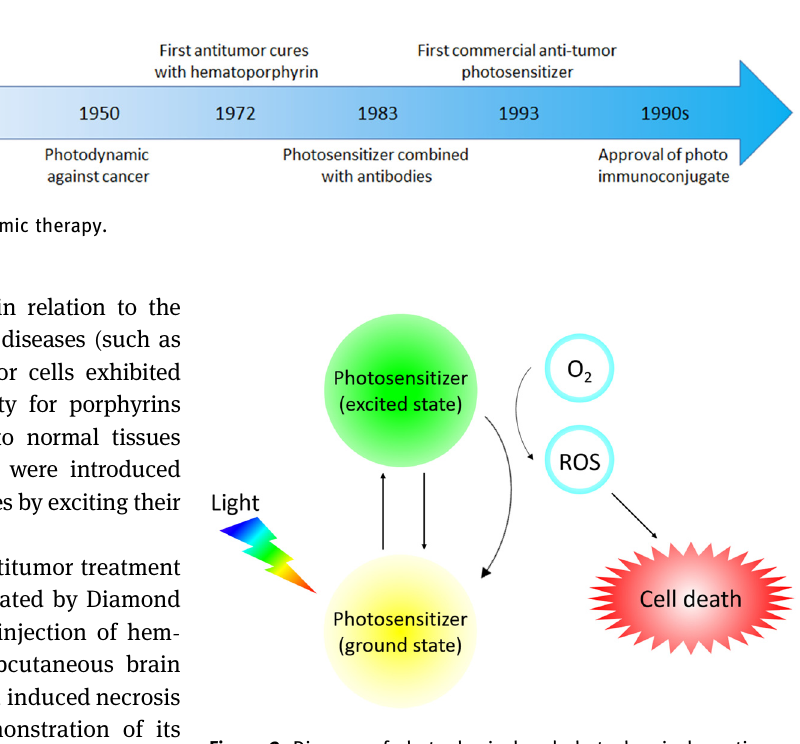
Figure 2: Diagram of photophysical and photochemical reactions during PDT. PS absorbs photons from a light source, and in its triplet excited state reacts with molecular oxygen, producing reacting species which then cause cell